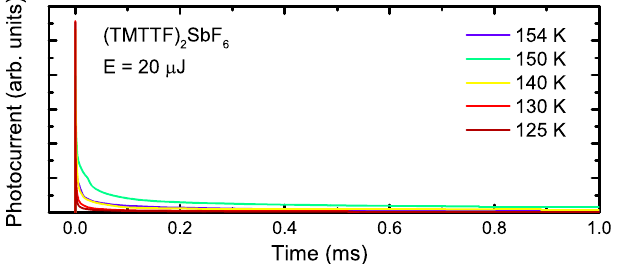
Figure 11. Simulation of a thermally induced photocurrent by a short laser pulse for five different temperatures as indicated. A steep current peak slowly relaxing to